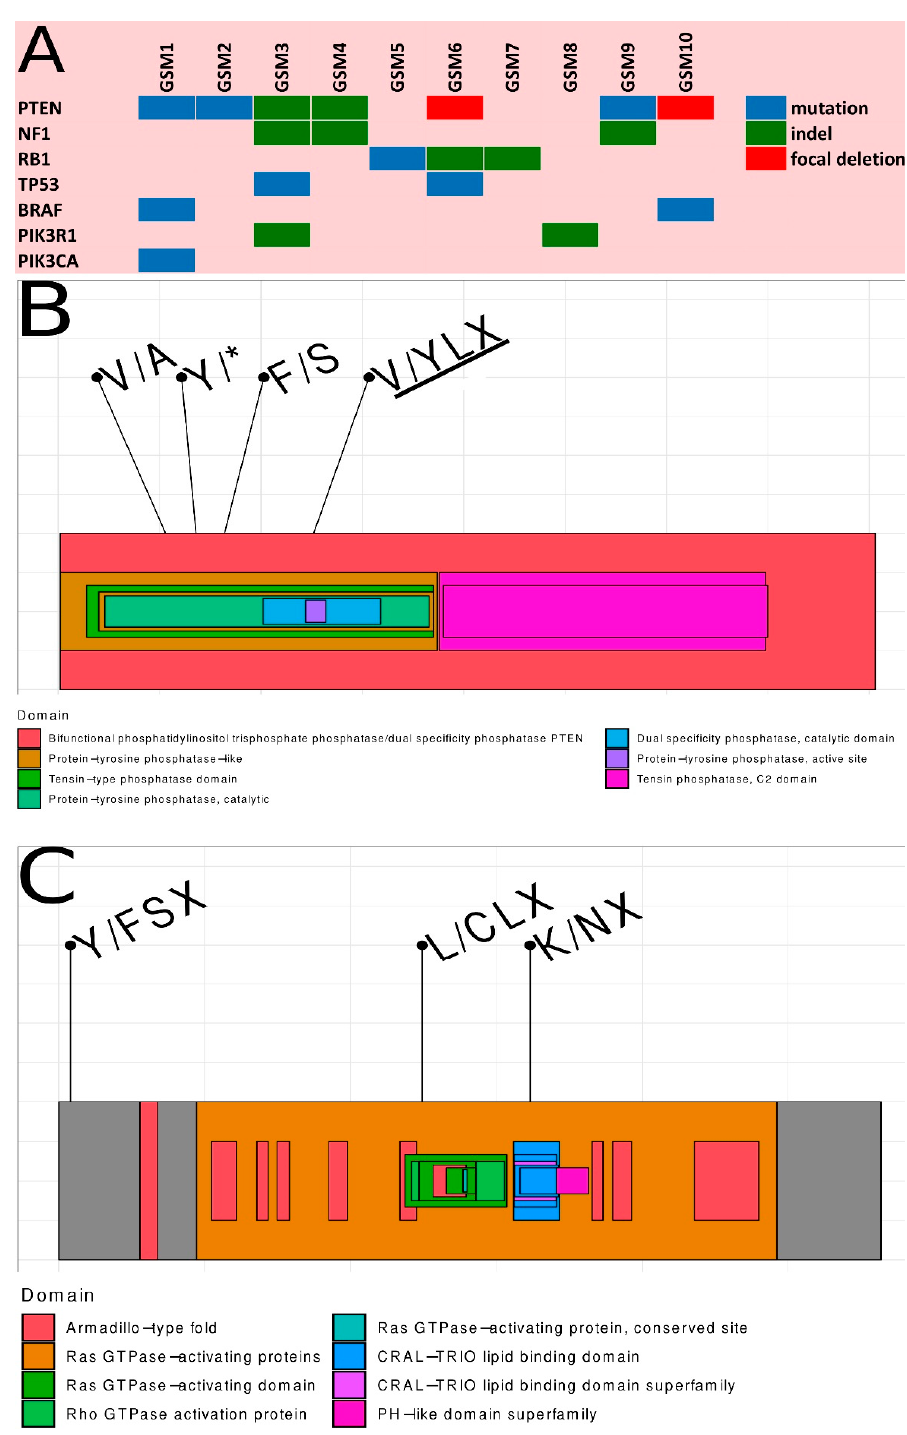
Figure 3. Detailed description of specific genetic alterations in each of the 10 samples. ( A ) Summary of somatic alterations with seven most frequently altered genes. ( B ) A view of the PTEN protein with marked positions of occurring somatic alterations. ( C ) A view of the NF1 protein with marked positions of occurring somatic alterations.